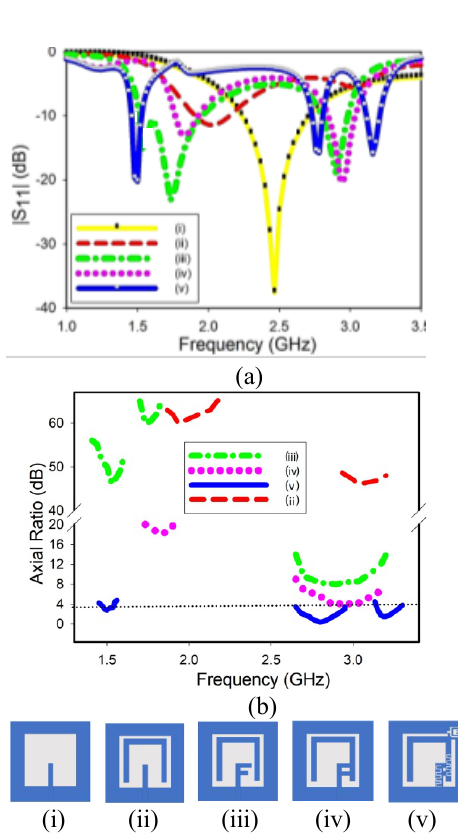
Figure 3: Design evolution of proposed antenna and its effects on the simulated : (a) reflection coefficient curves and (b) axial ratio values with frequency.